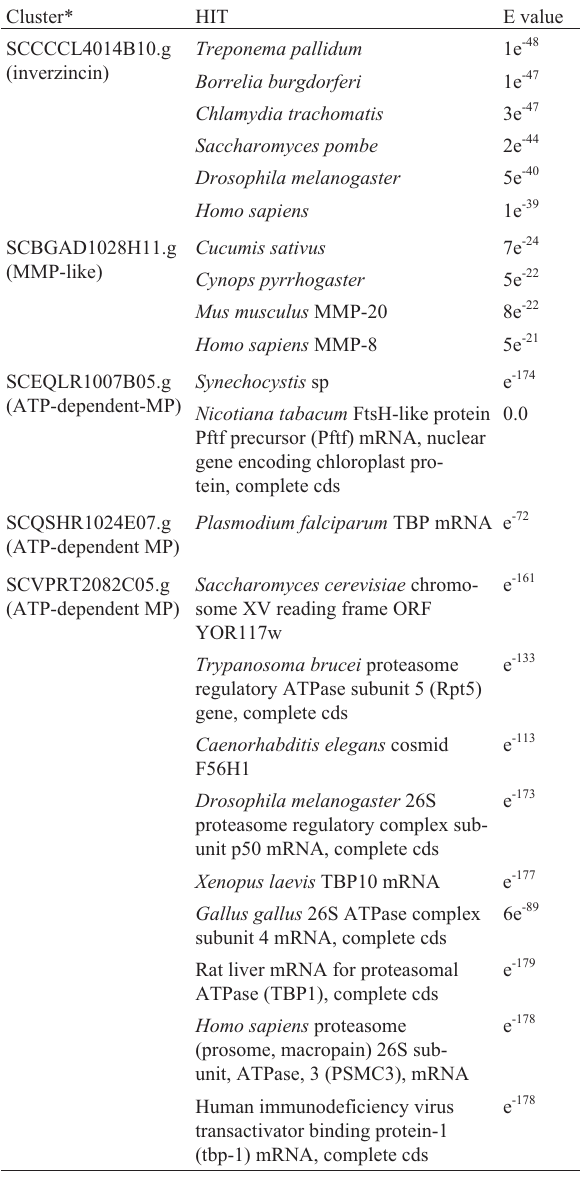
Table II - Comparison of sugarcane metalloproteases against NCBI data bank: Hits found with the Inverzincins cluster, MMP-like cluster, and ATP-dependent